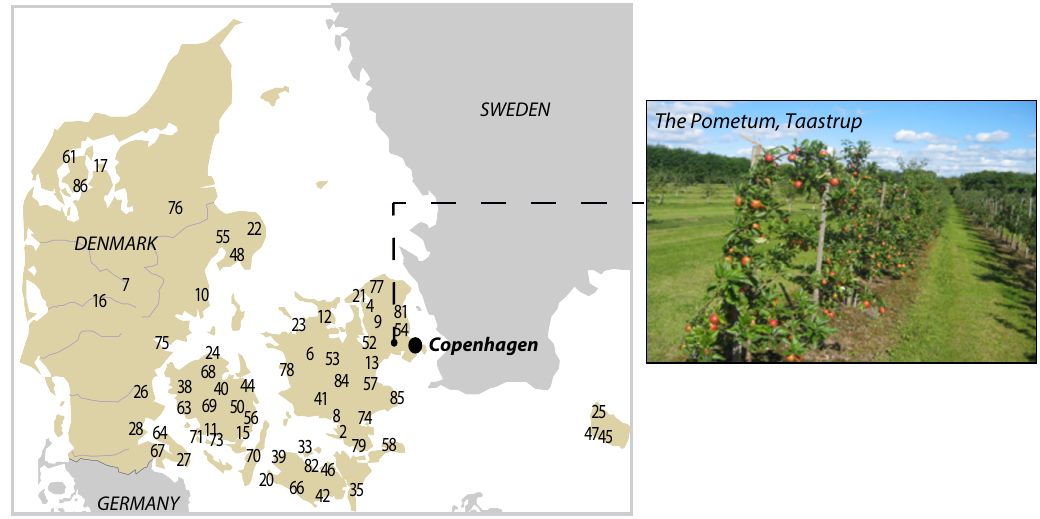
Figure 1. Geographical location of the University of Copenhagen ‘Pometum’ that hosts the collection of national and international fruit genotypes. The numbers on the map refer to the sample number in Table 1 and show the place of origin of the Danish